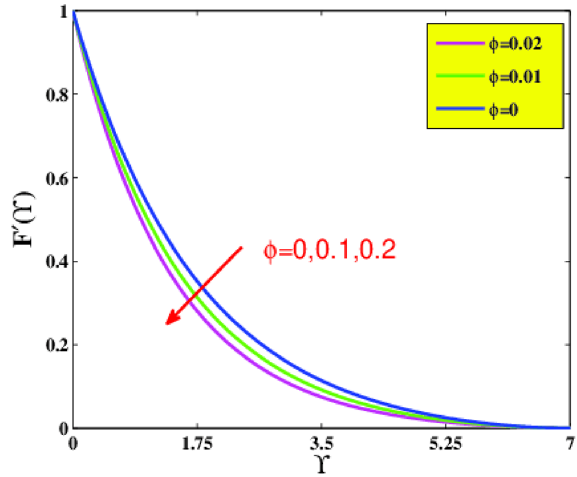
Figure 6. Velocity F ′ (ϒ) via φ .